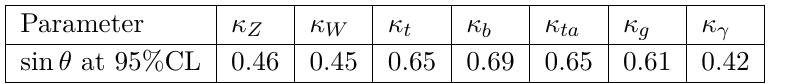
at Z/W/t/b/τ/g/γ